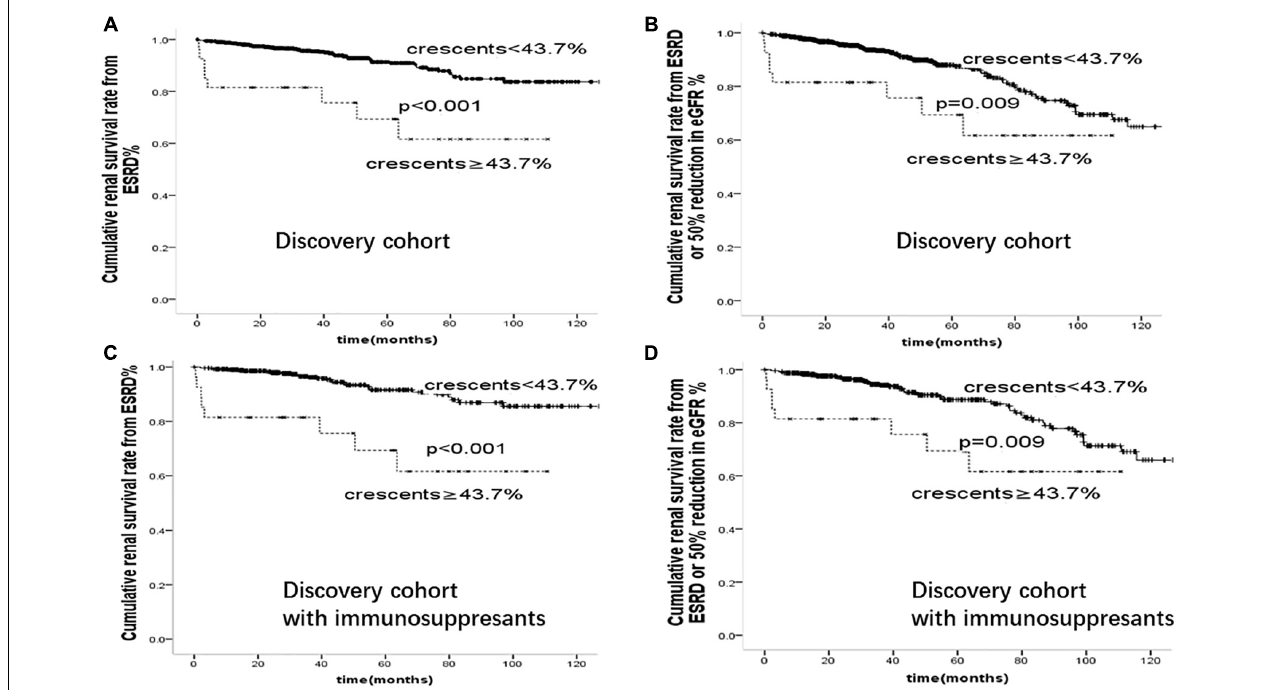
FIGURE 4 | Cumulative renal survival rate from (A) : ESRD (B) : ESRD or 50% reduction in eGFR in 894 cases of IgAN patients. Cumulative renal survival rate from (C) : ESRD (D) : ESRD or 50% reduction in eGFR in 529 cases of IgAN patients treated with immunosuppressants.